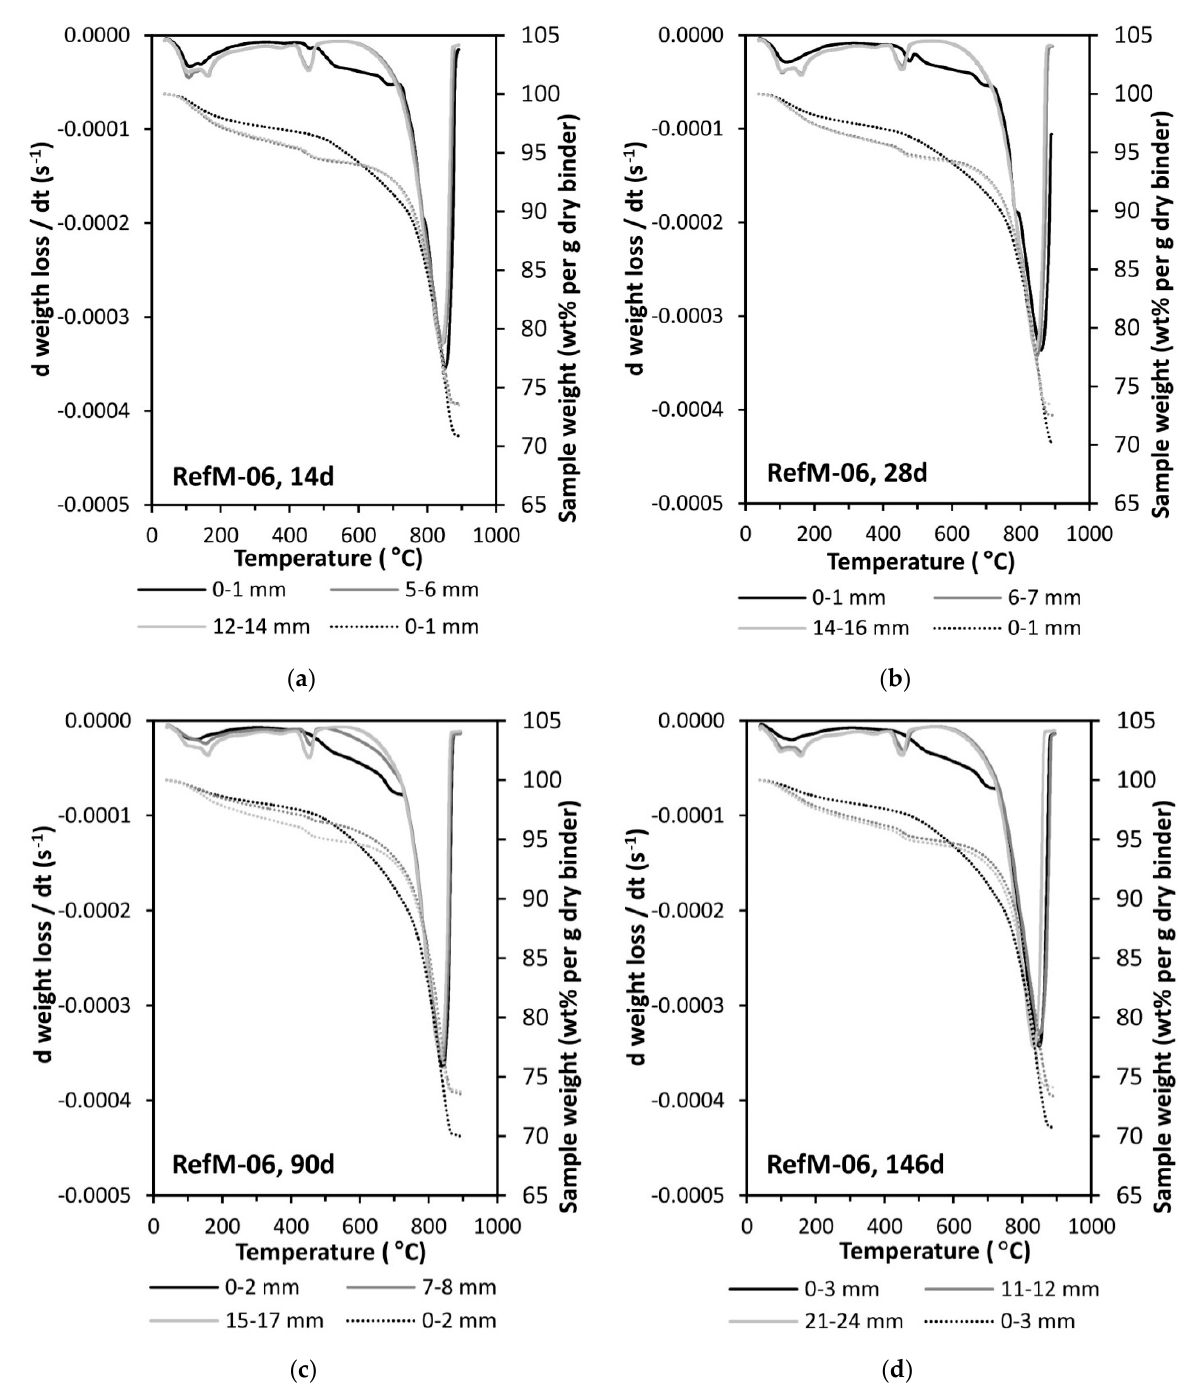
Figure A1. Differential thermal analysis (DTG) results obtained on EnDurCrete mortar, EnM-06, after ( a ) 14, ( b ) 28, ( c ) 90, and ( d ) 146 days of exposure to accelerated carbonation. Extension “-06” refers to the water-cement ratio of 0.6. Each graph shows the results of the top layer in black, the innermost layer in light grey, and one layer in between, in medium grey.